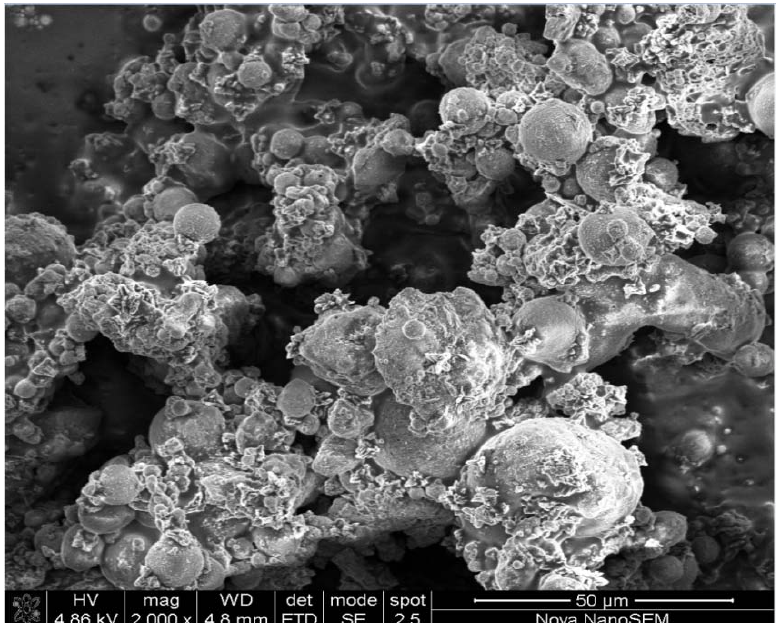
Figure 3. Micrographs taken of the products obtained after Run 3, at a magnification of 2000